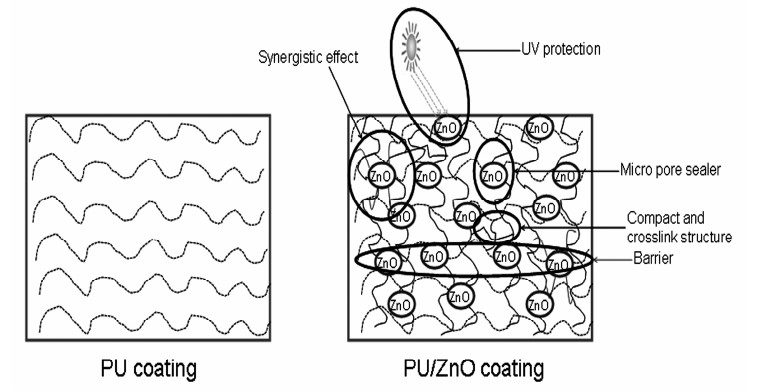
Table 8. Anti-UV-degradation properties of PU/ZnO